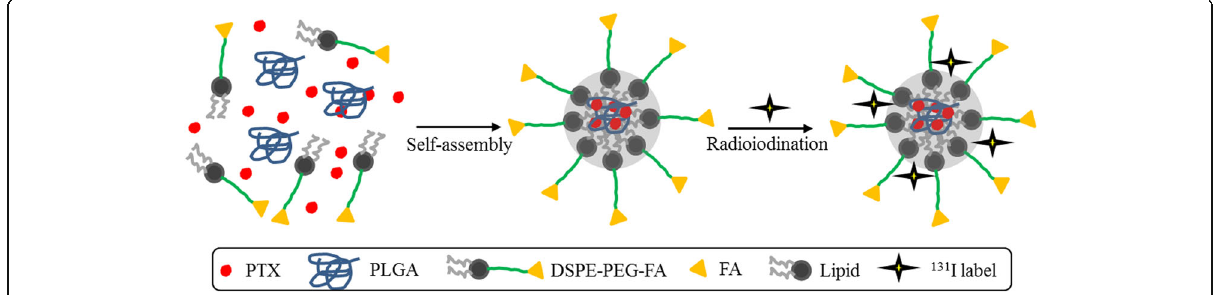
Fig. 1 Synthesis of FA-PLP- 131 I